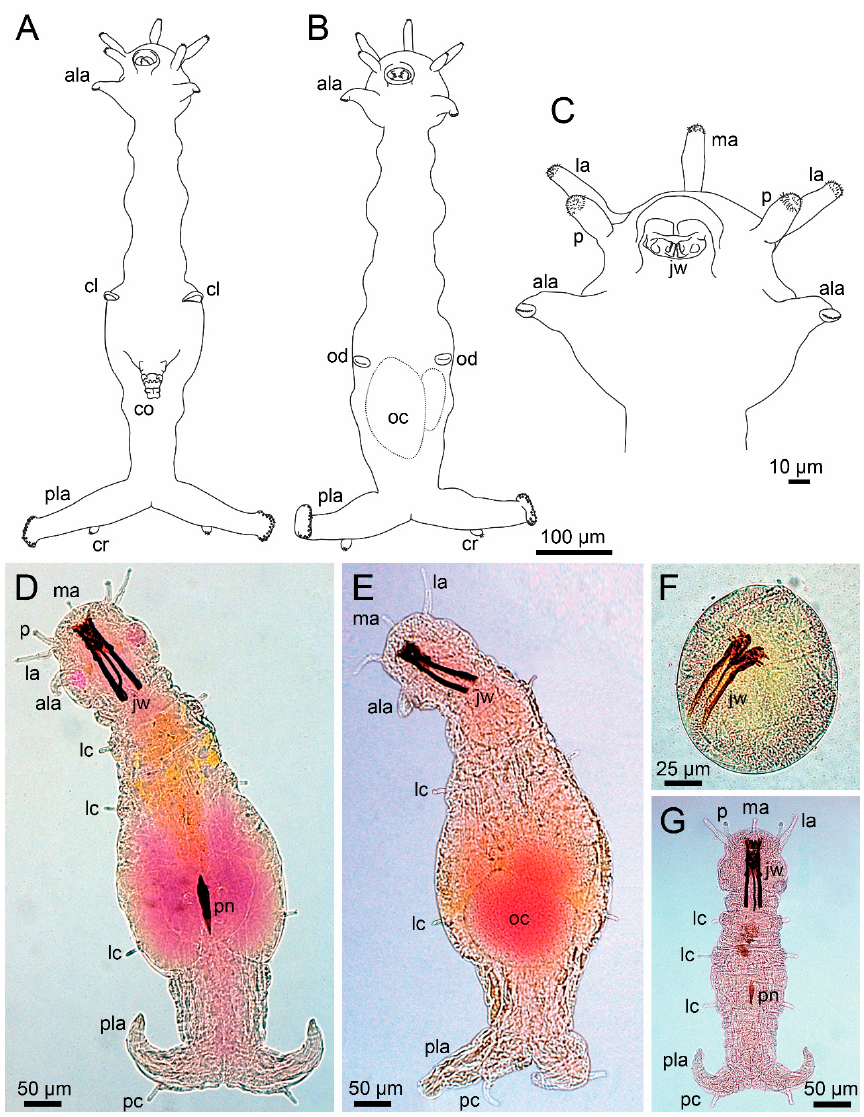
Figure 7. Morphology of Histriobdellidae. ( A ) Histriobdella homari , male, ventral view; ( B ) the same, female, ventral view; ( C ) the same, anterior end, ventral view; ( D ) Stratiodrilus arreliai Amaral and Morgado, 1997, male, ventral view; ( E ) the same, female, ventral view; ( F ) the same, early embryo; ( G ) the same, juvenile, ventral view. ala–anterior locomotory appendage, cl–clasper opening, co–copulatory organ, pc–posterior cirrus, jw–jaws, la–lateral antenna, lc–lateral